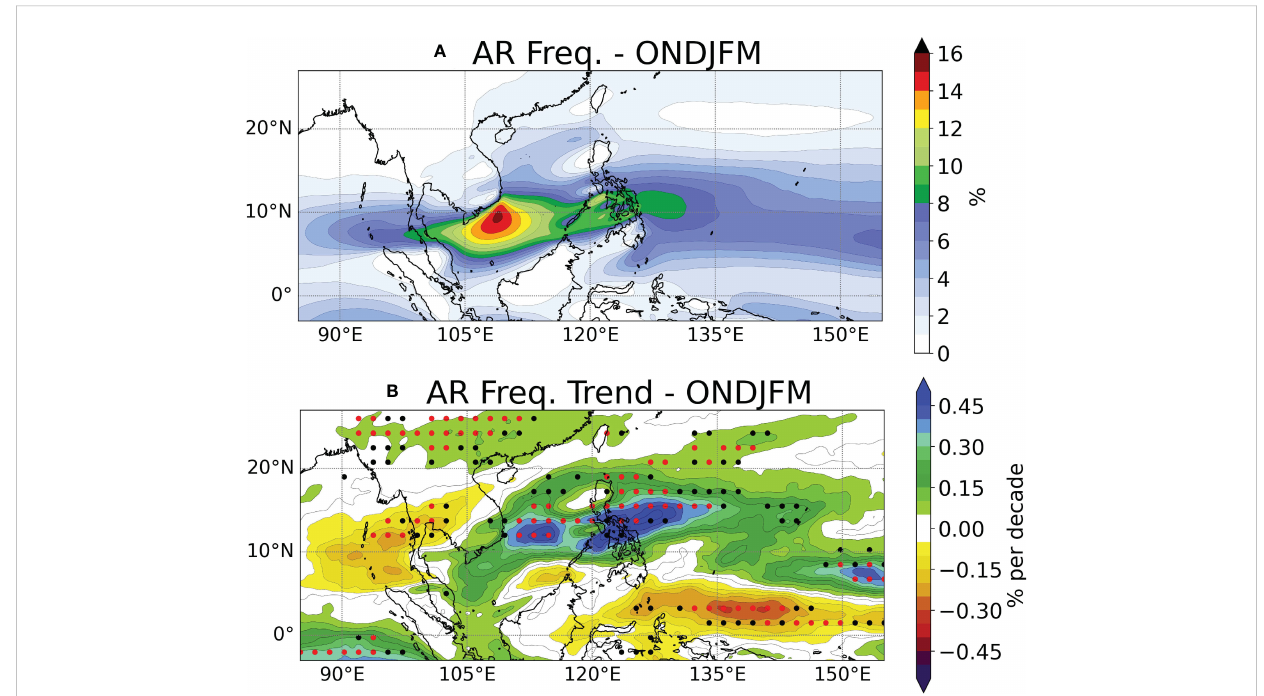
FIGURE 4 Distributions of AR frequency [ (A) , unit: %] and their trends [ (B) , unit: % per decade] for ONDJFM during the period 1951 – 2015. Red (black) stippling indicates statistically signi fi cant trends with con fi dence levels above 95%